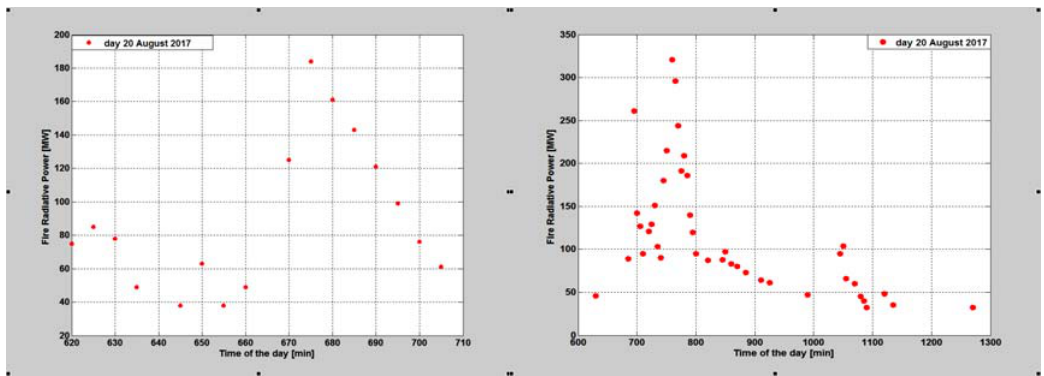
Figure 8. Comparison of the behavior of two fires that occurred on 20 August 2017 through the temporal variation of the of Fire Radiative Power (FRP). The fire behavior in the two cases is very different. The evolution of the fire shown in the left plot seems much more “regular” than the one shown in the right plot.